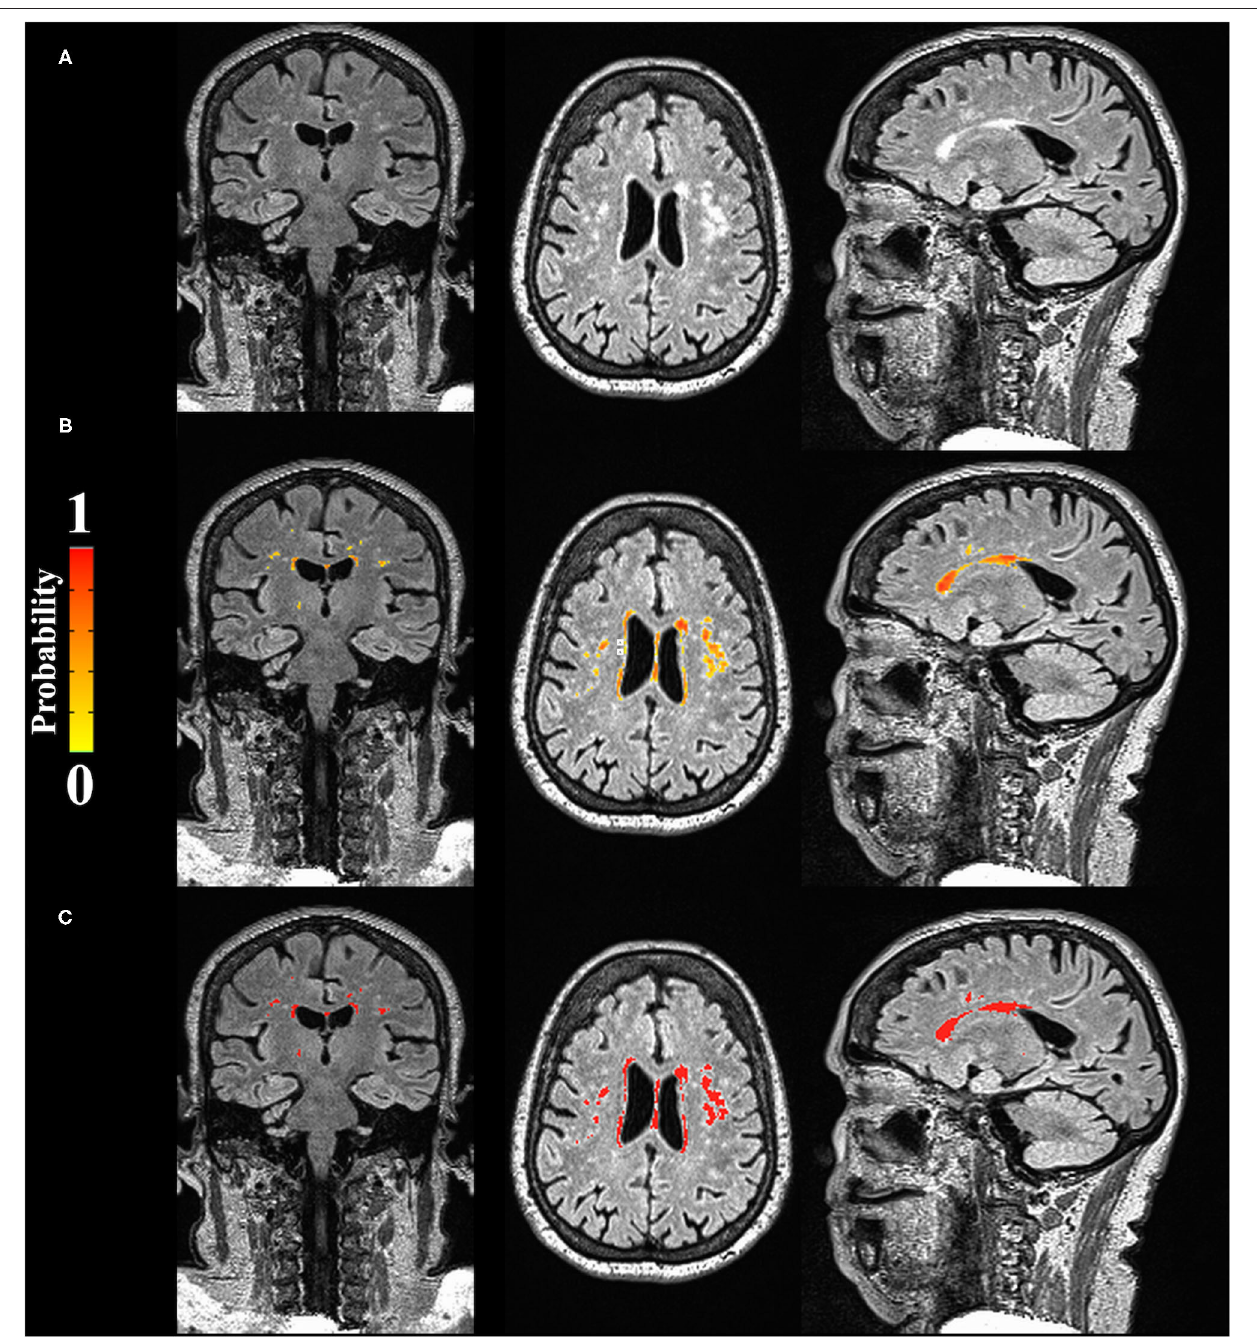
FIGURE 1 | Automatic segmentation of WMH (A) Raw data; (B) Probability map of WMH; (C) Binarized results of WMH (values above 0 were considered WMH).